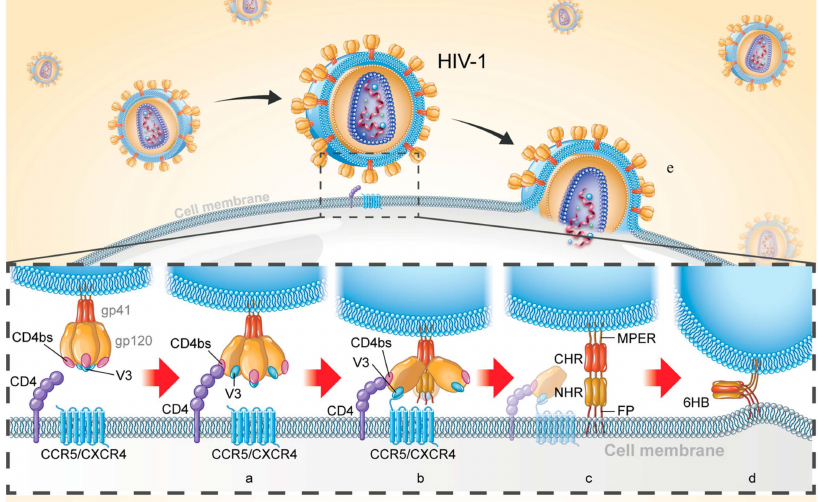
Figure 1. Schematic diagram of HIV-1 entry into target cell. ( a ) Binding of gp120 to CD4 receptor; ( b ) Binding of gp120 to the coreceptor CCR5 / CXCR4; ( c ) Formation of prehairpin intermediate (PFI) and connection of viral membrane and cell membrane; ( d ) Formation of six-helix bundle (6HB); ( e ) HIV-1 releases its genome into target